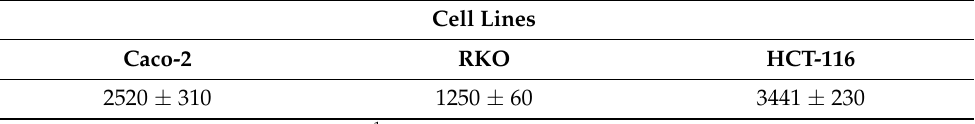
Table 3. IC 50 values for S. nigra flower aqueous extract on Human colorectal cancer cell